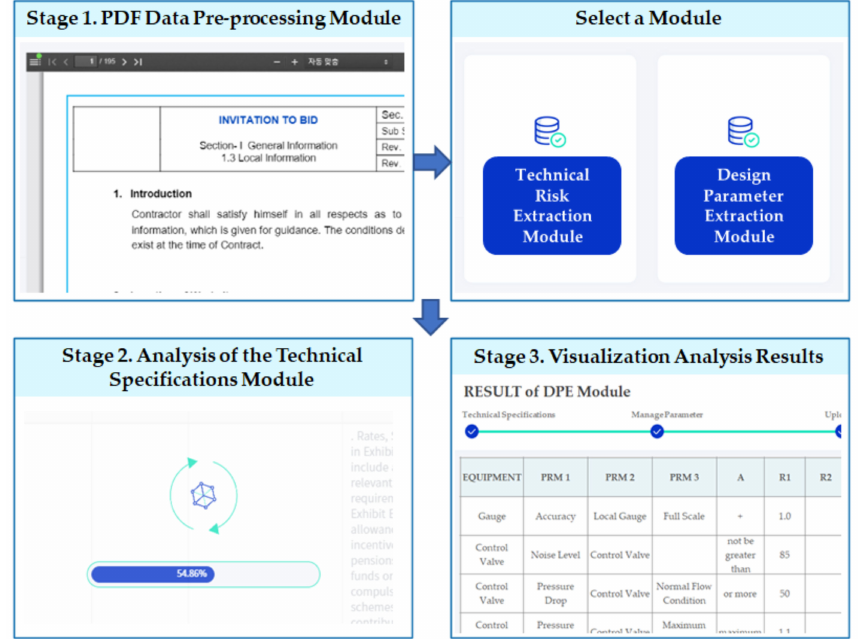
Figure 4. Design risk analysis